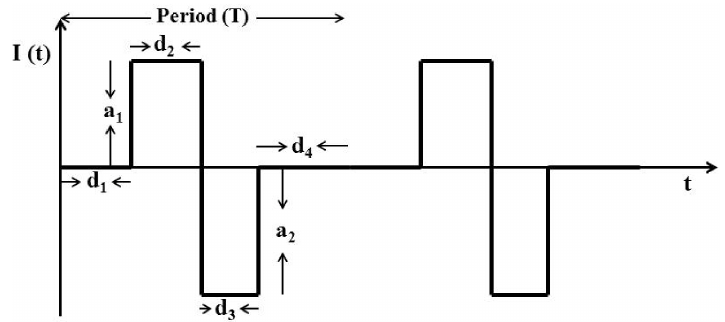
Figure 13. Charge-balanced Intra-cortical Micro-stimulation (ICMS) current in a biphasic waveform. (cid:82) T I ( t ) d t = 0 for T = ∑ 4 d i Here the net current i = 1 0